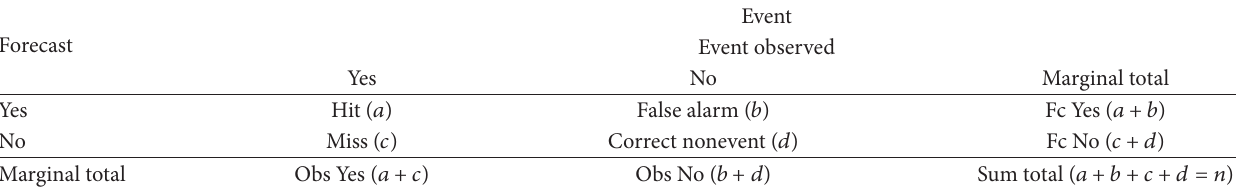
Table 6: Contingency table.